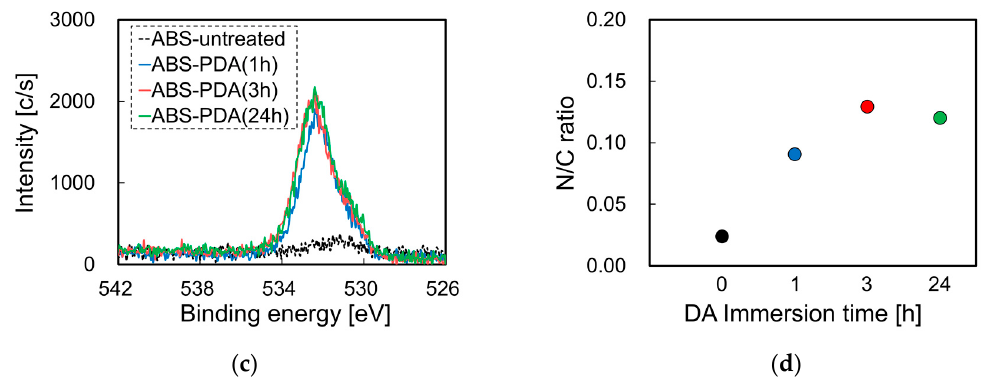
Figure 3. X-ray photoelectron spectroscopy (XPS) spectra of an ABS surface before and after PDA coating at different immersion times in a DA solution: ( a ) C1s-XPS, ( b ) N1s-XPS, ( c ) O1s-XPS, and ( d ) the N/C ratio.